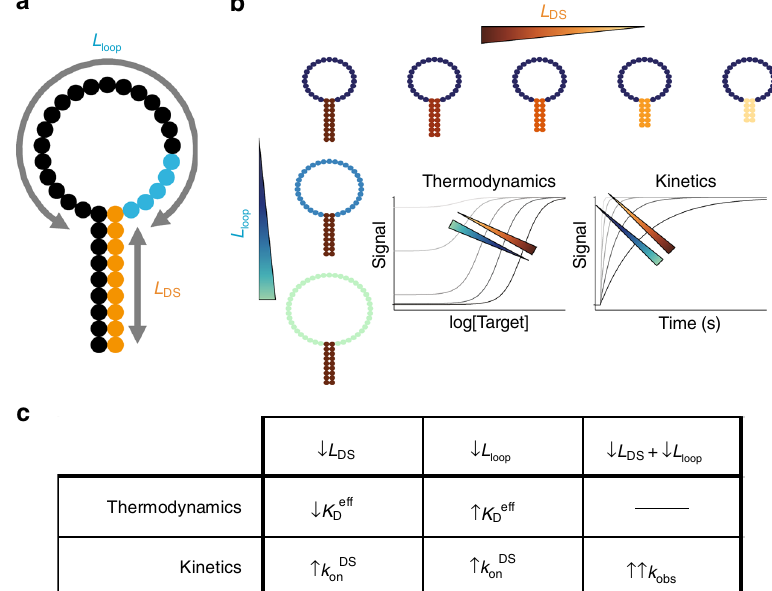
Fig. 2 ISD control parameters and their effects. a By modulating the length of the linker ( L loop ) and the number of bases in the hairpin ( L DS ) between the displacement strand and the aptamer, we can control both the kinetics and thermodynamics of our ISD switch. We describe our switches using the nomenclature of L DS _ L loop , i.e., a construct with a 9 bp displacement strand an a 33 nt loop is referred to as 9_33. b On one hand, reducing L DS increases effective binding af fi nity at the expense of increased background signal. On the other hand, decreasing L loop decreases background at the expense of lower effective binding af fi nity. c Decreasing either parameter increases the overall rate of binding, making it possible to increase the kinetics of a given construct while retaining the same K eff Þ , signal given by and the dissociation constant of the native aptamer ð K apt D